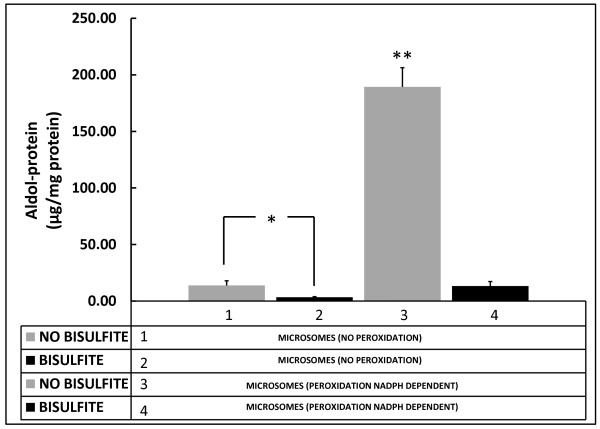
Aldol-proteins formation in the NADPH-dependent microsomal peroxidation. The products of catalyzed microsomal peroxidation increase the absorbance of the control sample at 266 nm by a factor of more than 14 (Bars #1 vs. #3). When sodium bisulfite was added at the end of the incubation period of peroxidation, the absorbance fell (Figure 3, #4), and reached values close to its control. Even in the control case, a fall of the initial amount could be observed with the addition of bisulfite (Bars #1 vs. #2). Bisulfite interferes directly with carbonyl groups derived from aldehydes in the aldolic condensation. * p < 0.01; **p < 0.0001 compared with all the other groups.